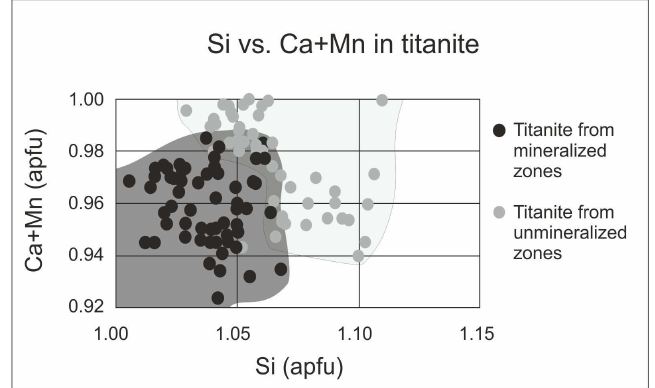
Figure 7. Si vs. Ca + Mn content of titanite from mineralized and unmineralized zones. Different fields—albeit with some overlapping—can be assigned.